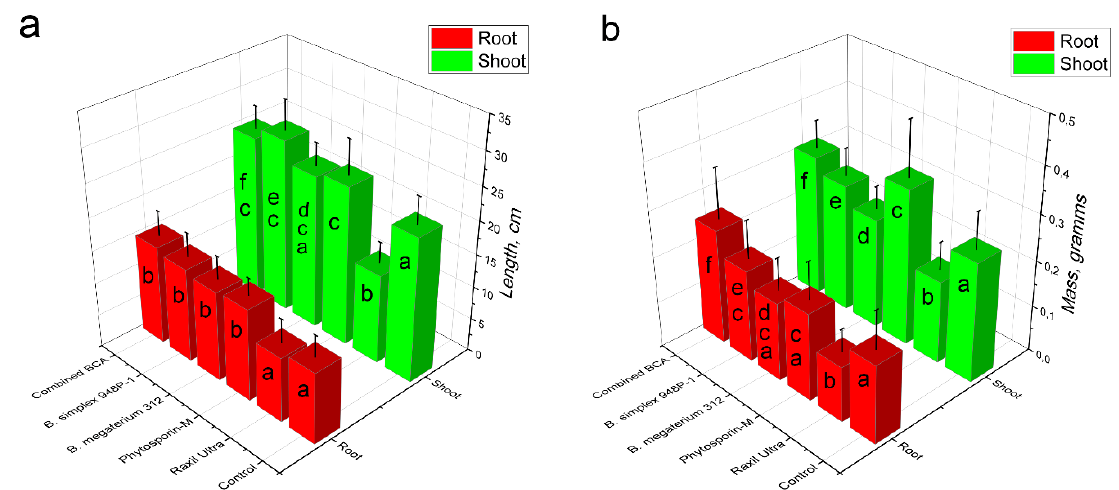
Figure 2. Influence of strains of the genus Bacillus spp. on the morphometric parameters of wheat seedlings (Triticum aestivum L.). The length ( a ) and biomass ( b ) of wheat seedlings were assessed by measurements on the 14th day of the treatment. Treatments not connected by the same letter in each bar are significantly different from each other ( p < 0.05; means ± SD).